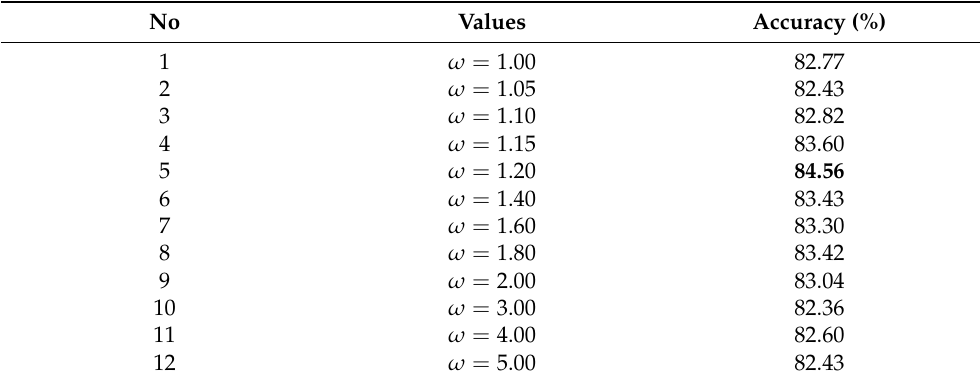
Table 2. Effect of the parameter ω on the AM-CNN model.